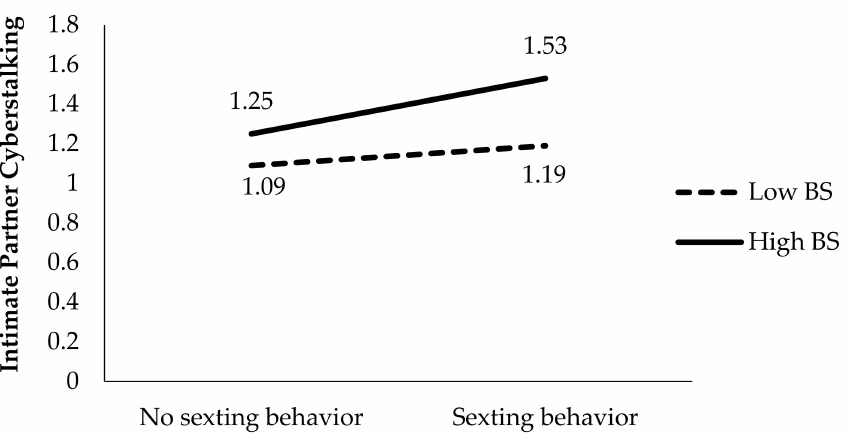
Figure 1. Moderating effect of benevolent sexism (BS) between sexting behavior and intimate partner